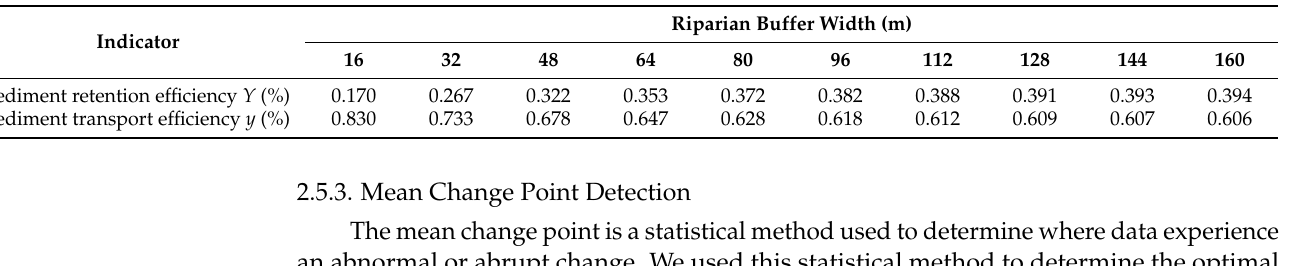
Table 1. Sediment interception efficiency and sediment transport efficiency of riparian buffers with various